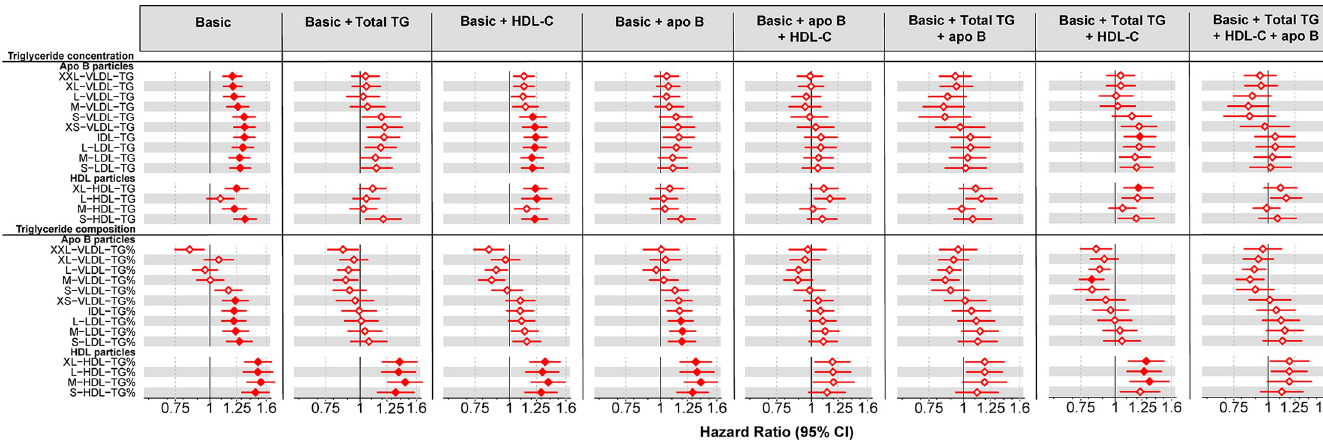
Fig 6. Observational associations of circulating triglyceride concentrations and triglyceride composition in lipoprotein subclass particles and risk of incident CHD with multiple adjustments. Hazard ratios for incident CHD per SD higher circulating triglyceride concentrations (upper part) and triglyceride composition (lower part) in lipoprotein subclass particles within each size-specific lipoprotein subclass adjusted for traditional risk factors and gradually for 3 fundamental measures that characterize the overall lipoprotein profile pretty well, namely, total serum triglyceride (total TG), HDL cholesterol (HDL-C), and apolipoprotein B (apoB) concentration. Closed circles represent statistical significance of associations at P < 0.002 and open circles associations that are nonsignificant at this threshold. The horizontal bars refer to the 95% CIs. Underlying data can be found in S1 Data. Apo B, apolipoprotein B; C, cholesterol; CHD, coronary heart disease; HDL, high-density lipoprotein; IDL, intermediate-density lipoprotein; LDL, low-density lipoprotein; TG, triglycerides; VLDL, very-low-density lipoprotein.